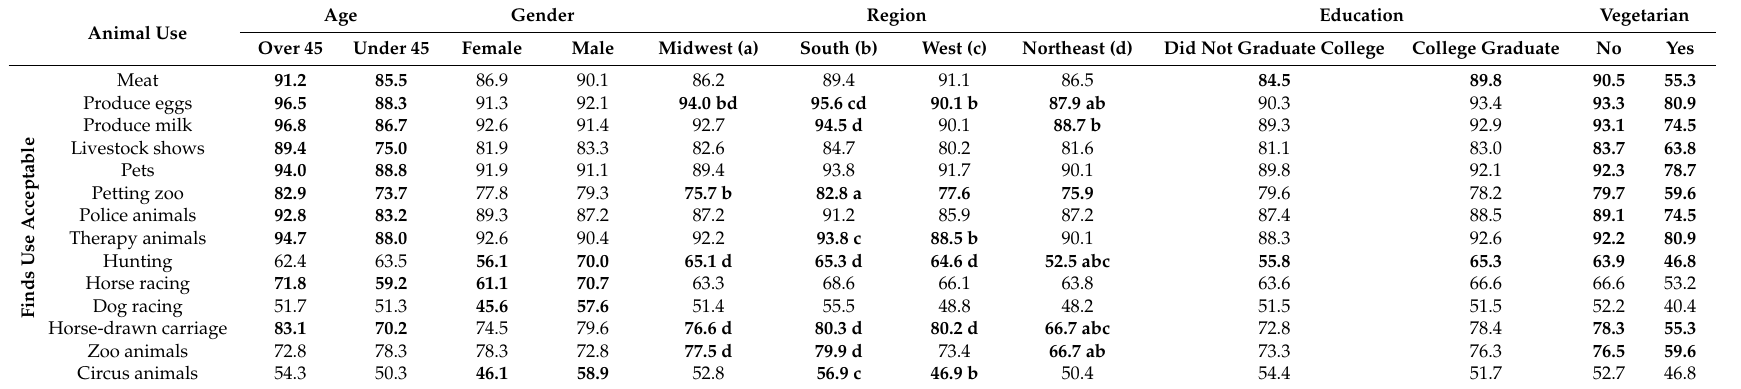
Table 3. Cross tabulations between acceptable animal uses and